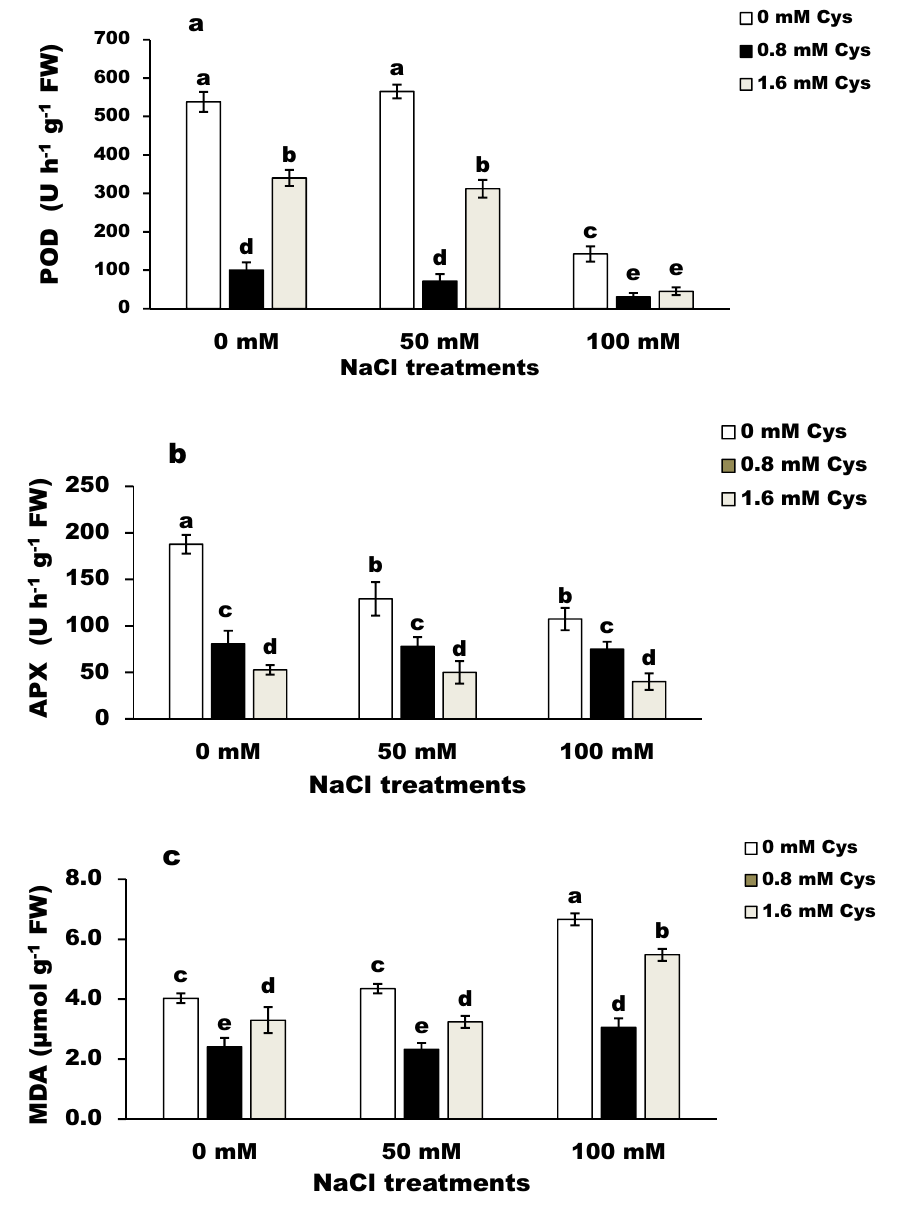
Figure 3. Effect of L-cysteine on the activity of POD ( a ) and APX ( b ) and lipid peroxidation ( c ) in salt-stressed flax plants. Differences are statistically significant at p < 0,05; vertical bars indicate ±